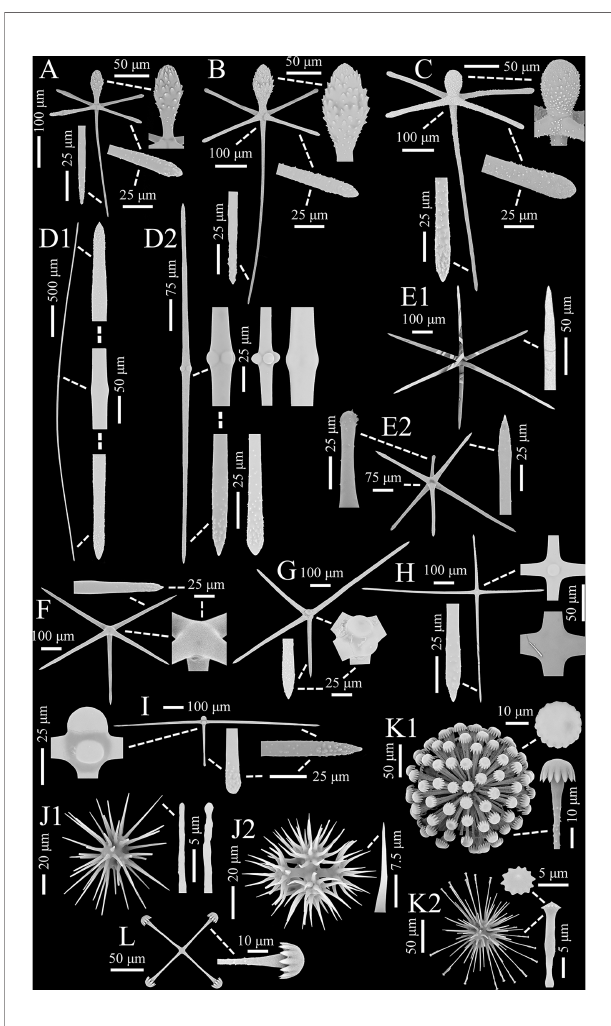
FIGURE 2 | Flavovirens hemiglobus gen. et sp. nov., spicules of holotype (SEM). (A) Pinular dermal hexactin, whole and enlarged ray ends. (B) Pinular atrial hexactin, whole and enlarged ray ends. (C) Pinular marginal hexactin, whole and enlarged ray ends. (D) Two types of choanosomal diactins, whole and enlarged tips and center. (E) Two types of choanosomal hexactins, whole and enlarged ray ends. (F) Choanosomal pentacin, whole and enlarged tip and cross center. (G) Choanosomal tetractin, whole and enlarged tip and cross center. (H) Choanosomal stauractin, whole and enlarged tip and cross centers. (I) Choanosomal triactin, whole and enlarged tips and cross center. (J) Two examples of oxyhexasters, whole and enlarged secondary ray tips. (K) Two types of discohexasters, whole and enlarged secondary ray tip and terminal disc. (L) Staurodisc, whole and enlarged ray